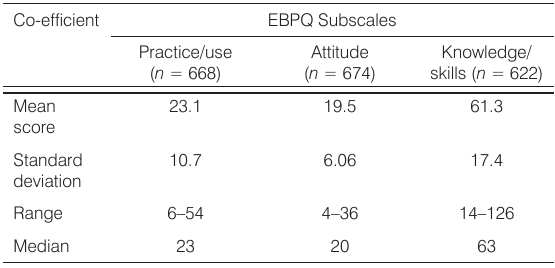
Table 2. Descriptive statistics for the self-reported EBP use, attitude, and knowledge/skills.